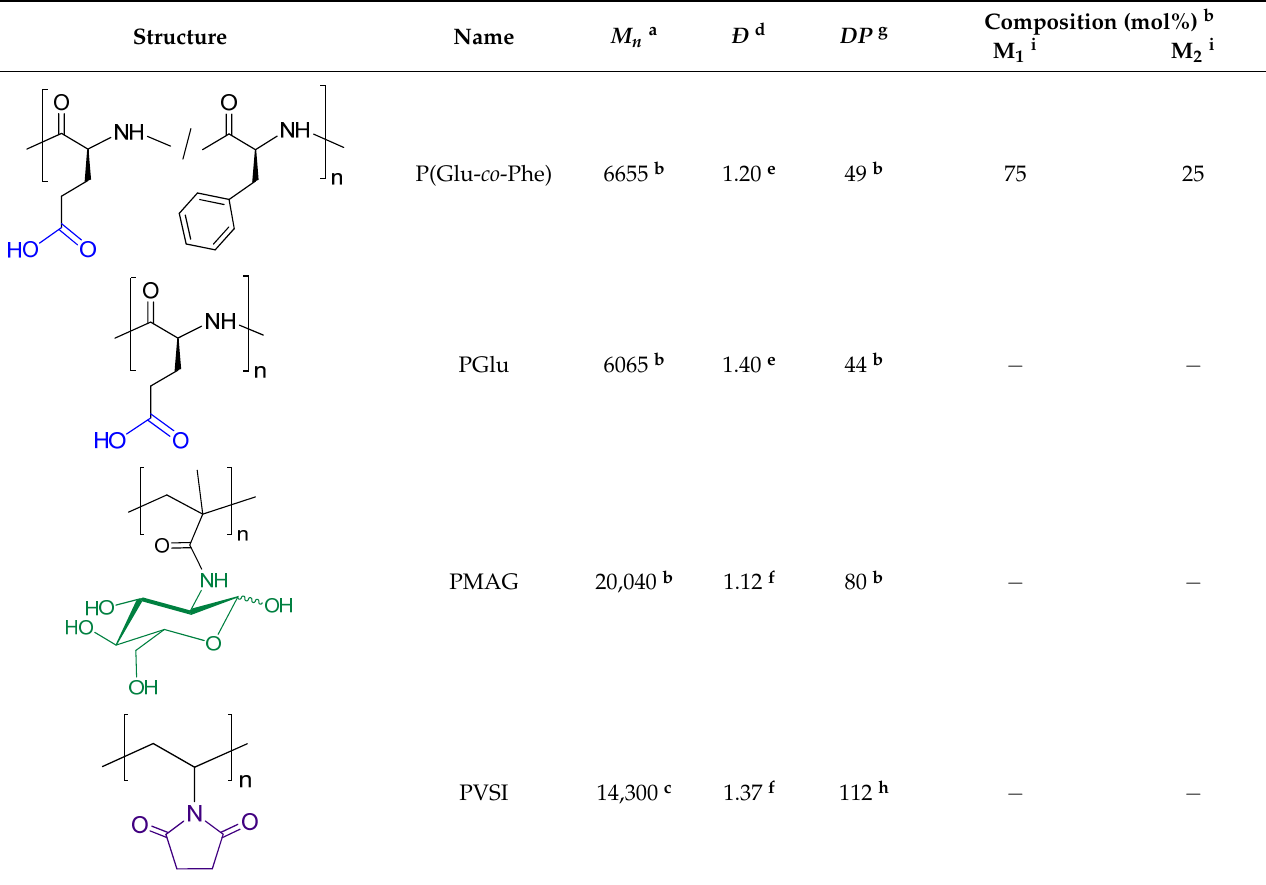
Table 1. Structures and characteristics of polymers used as carriers for PMX B.